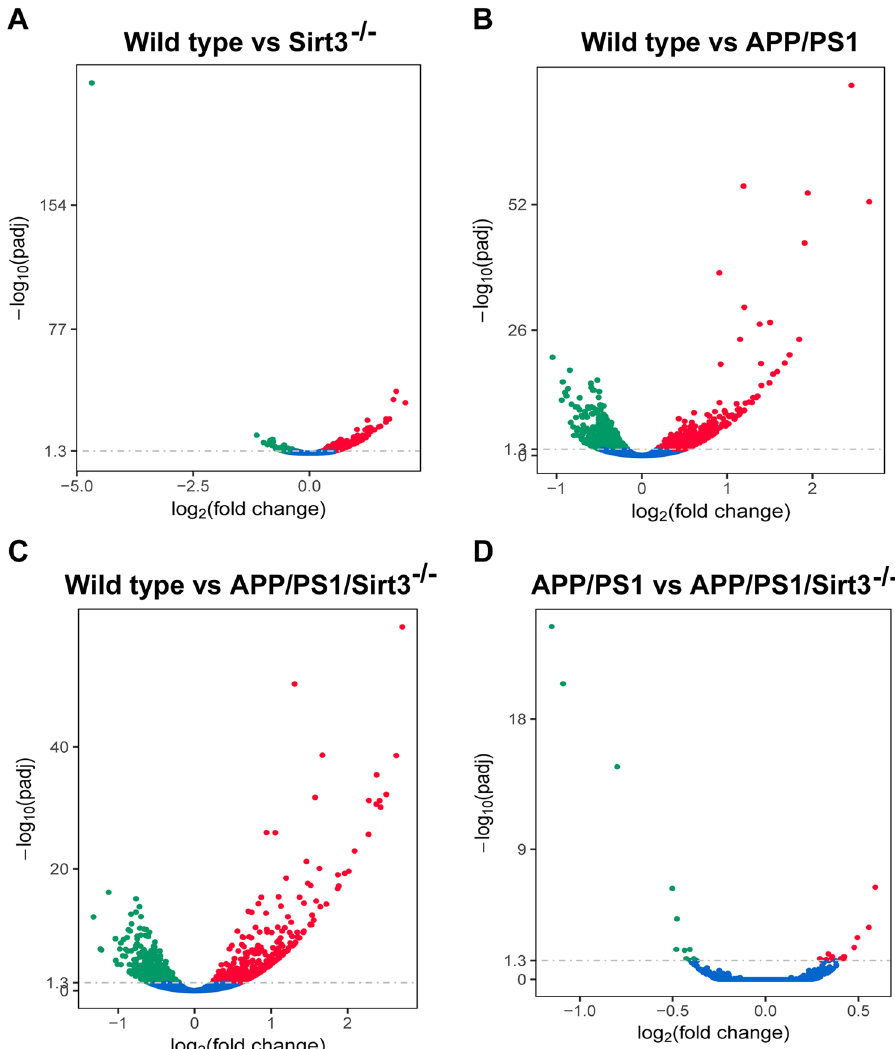
and downregulated (green) genes were drawn. Comparisons were made to determine the effects of Sirt3 gene deletion ( A ), amyloid plaque deposition ( B ) and the combination ( C ). Comparisons were also made to determine the effects of Sirt3 gene deletion in APP/PS1 mice ( D